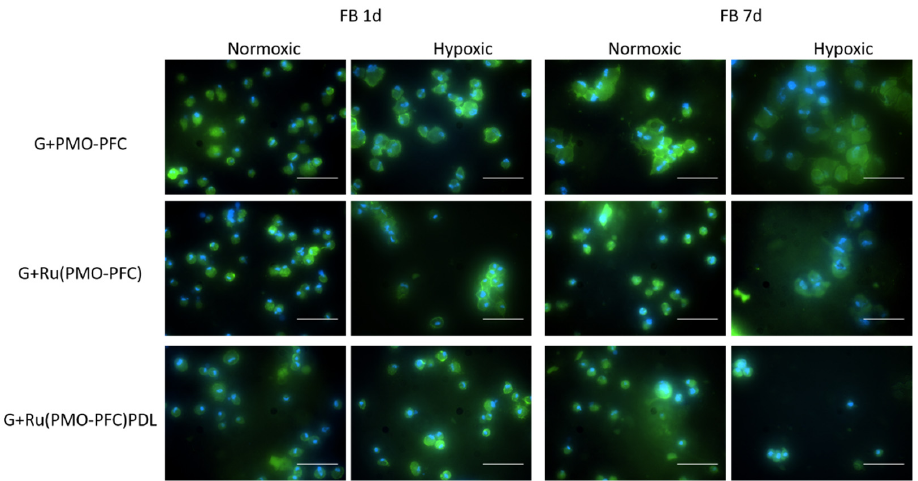
Figure 8. Fluorescence images of FB cells on NC ‐ hydrogel scaffolds under normoxia and hypoxia conditions for 1d and 7d incubation times. Scale bar equals 50 μ